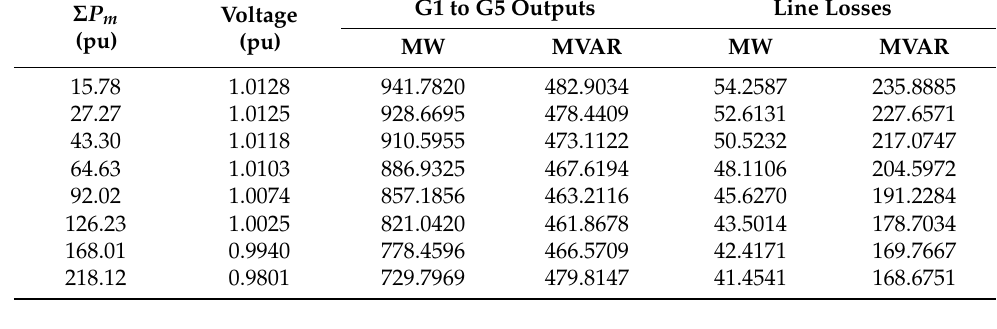
Table 15. WPP voltages, G1 to G5 power outputs and line losses (PF = 0.95 lagging).